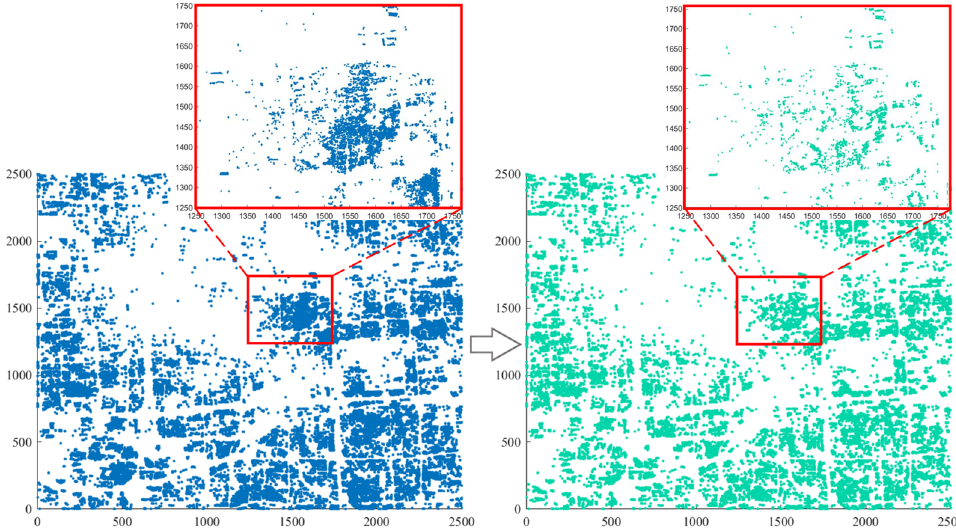
Figure 1. Comparison diagram of weak coverage point distribution before and after deleting “noise” points.